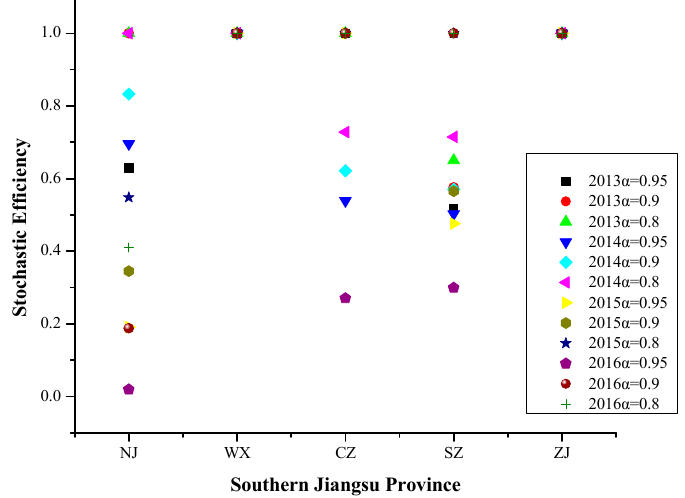
Figure 6. Stochastic efficiency values in southern Jiangsu Province at different risk levels in 2013– 2016.